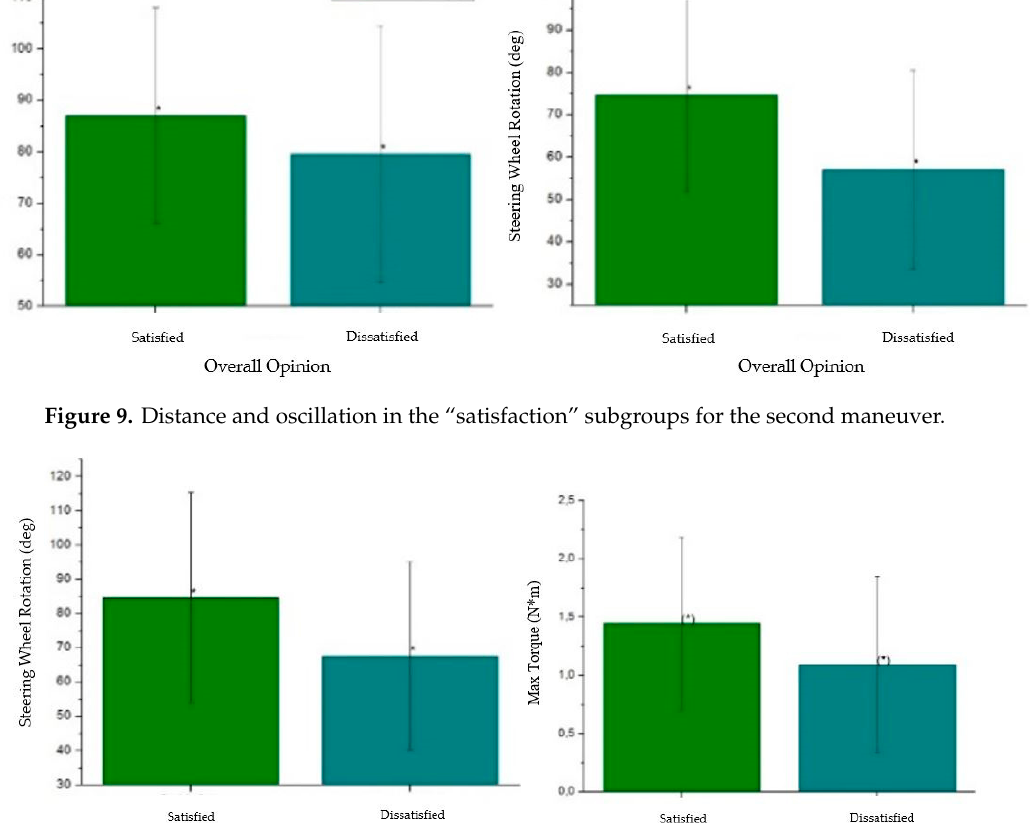
Figure 10. Oscillation and torque detected in the “satisfaction” subgroups for the third maneuver.